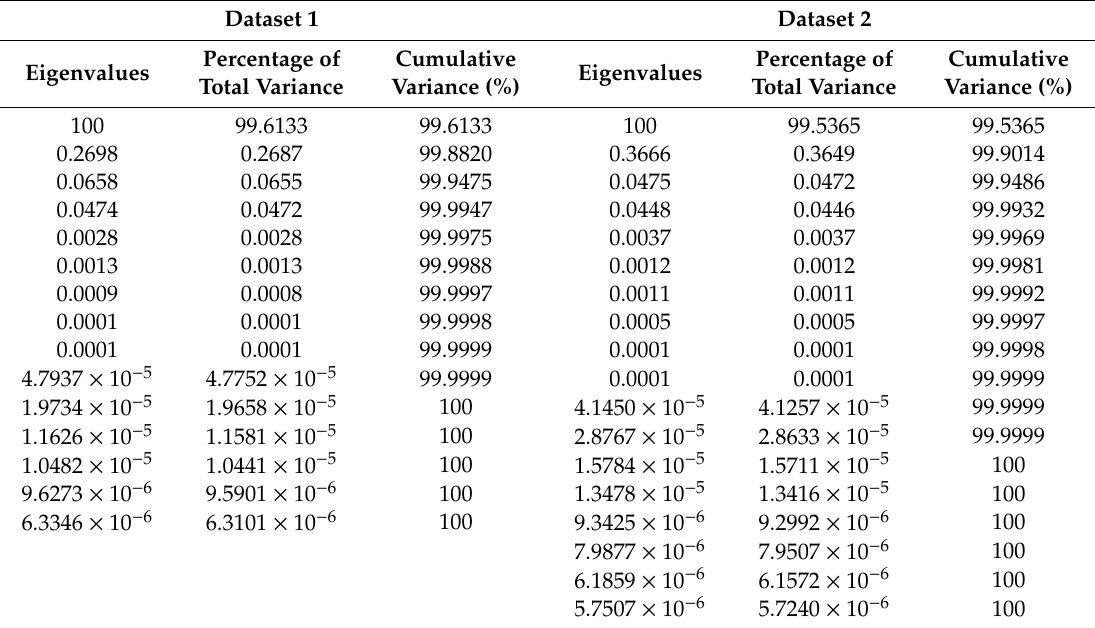
Table 3. Eigenvalues for both datasets of the heating